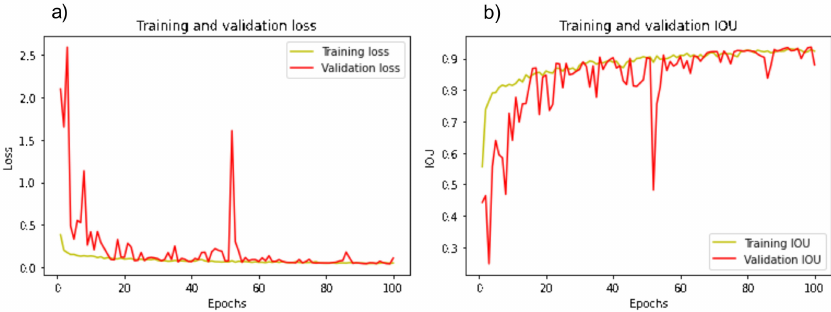
Figure 22. The result of training and validation ( a ) loss and ( b )